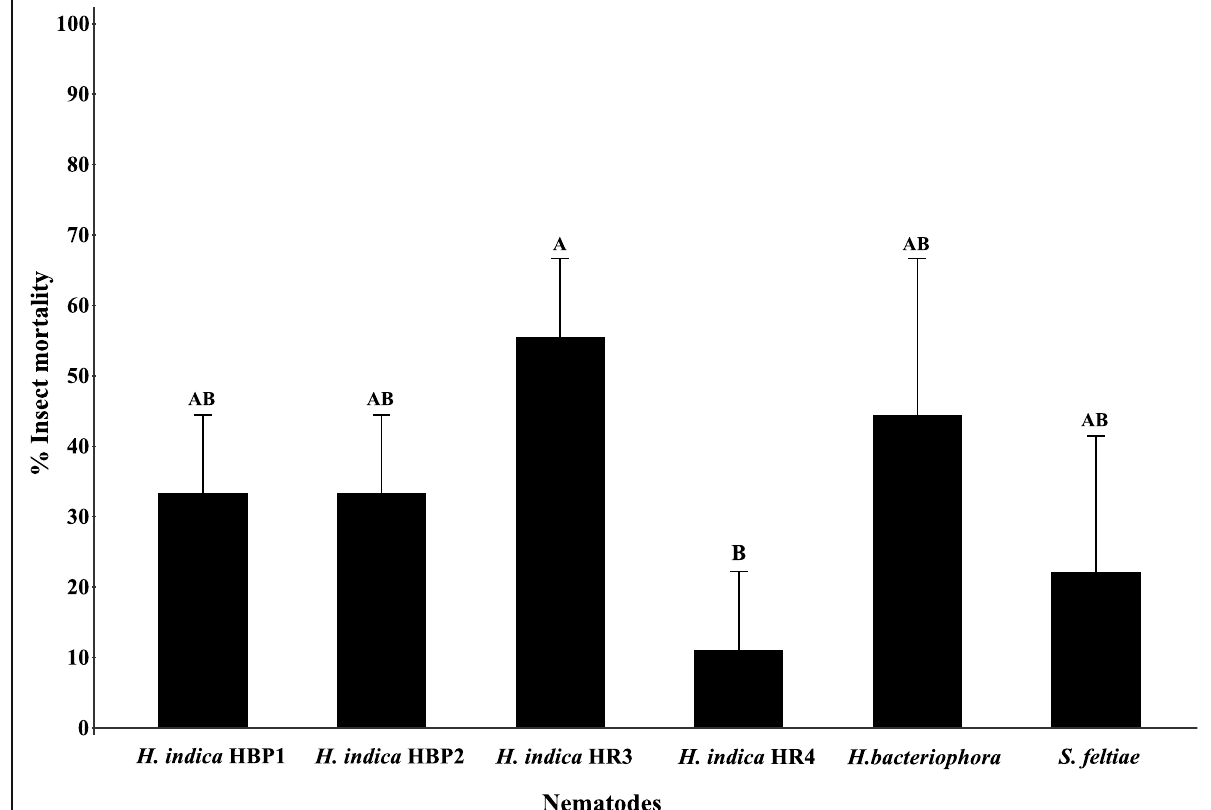
Fig. 2 Percentage mortality of the four native Heterorhabditis indica (HBP1, HBP2, HR3, HR4) isolates and the commercial nematodes Heterorhabditis bacteriophora and Steinernema feltiae against Zophobas morio larvae at 25±2 °C 1 week after infective juvenile (IJ) inoculation. Error bars indicate standard deviations with three replications. Different letters above error bars indicate significant differences between strains and lines (Tukey ’ s HSD test; p ≤